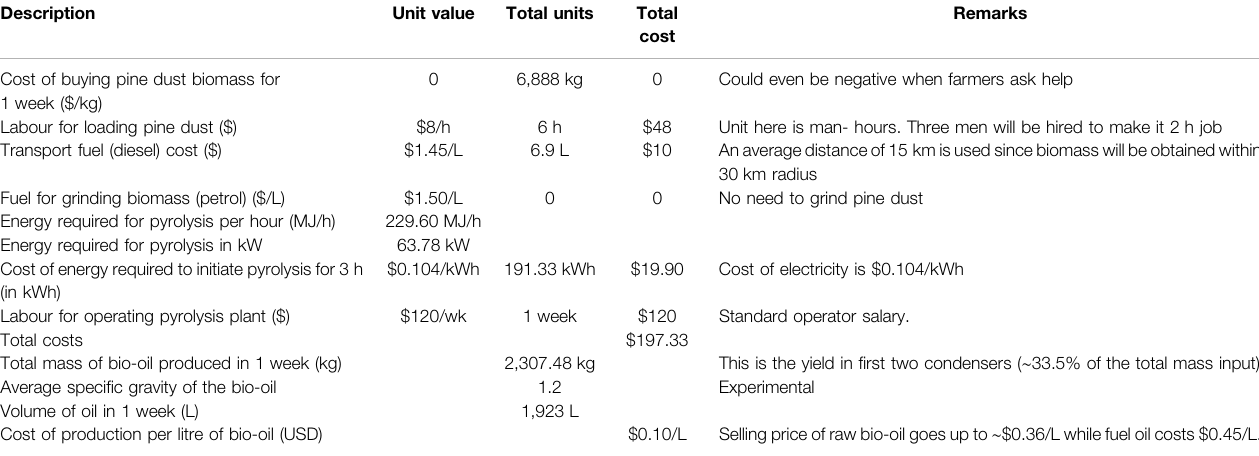
TABLE 6 | A preliminary cost analysis for the production of bio-oil within the local context.